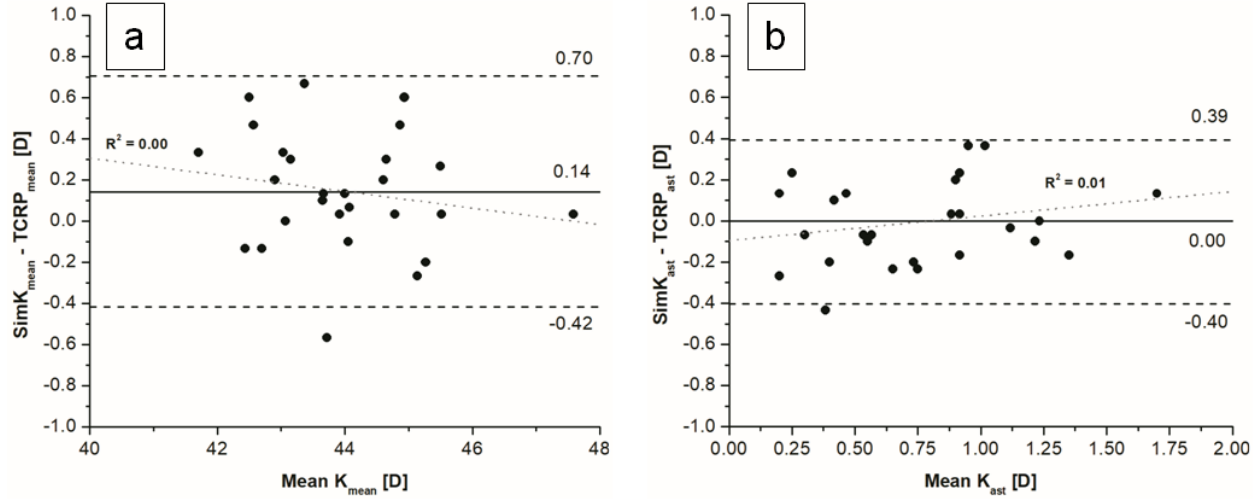
Figure 2. Bland–Altman plots of comparison between simK and TCRP using ( a ) mean values, ( b ) astigmatism